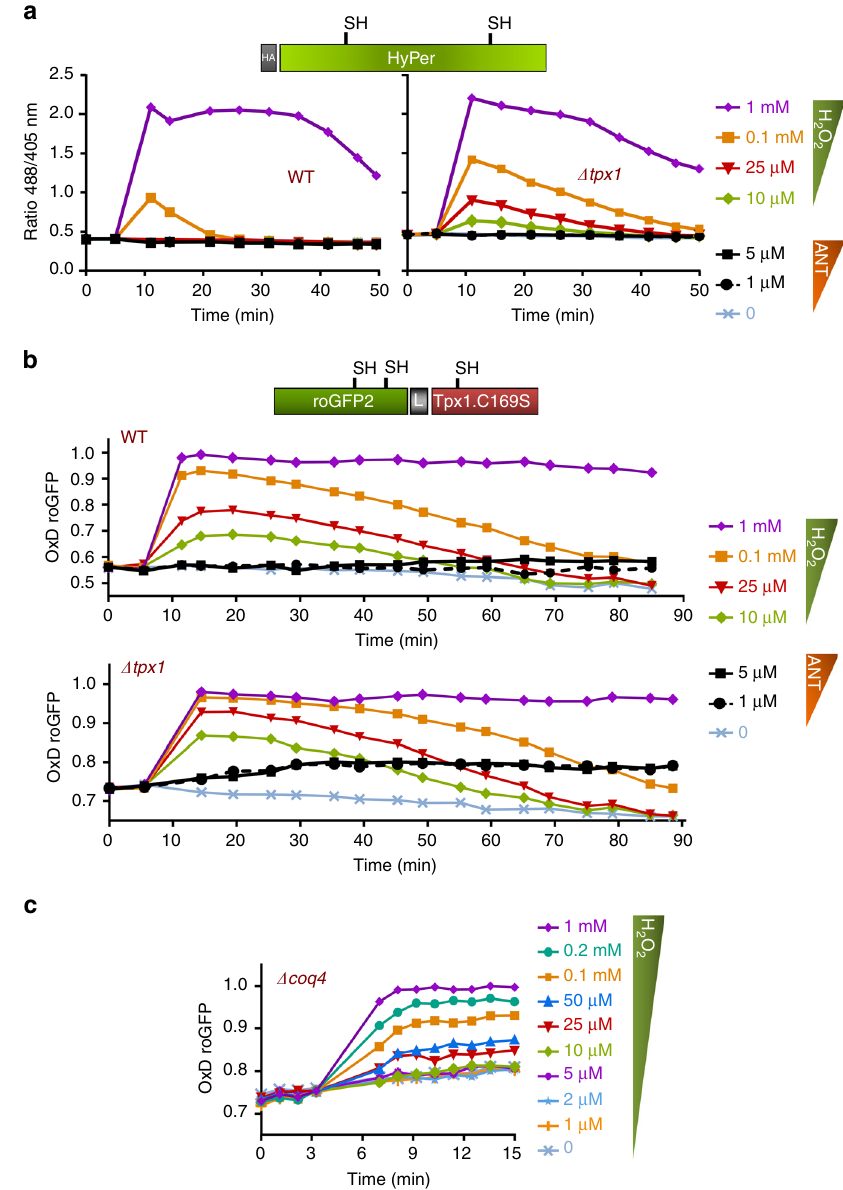
Fig. 5 Cytosolic roGFP2-Tpx1.C169S can detect mitochondrial H 2 O 2 production. Strains HM123 (WT) and SG5 ( Δ tpx1 ) were transformed with plasmids p605 ( a ) and p407.C169S ( b ). The indicated concentrations of H 2 O 2 and antimycin A (ANT) were directly added to MM cultures and oxidation of the reporters was estimated as described in Fig. 1; oxidation of the probe upon ANT treatments is represented with solid (5 µ M ANT) or dashed (1 µ M ANT) black lines. a Data from two biological replicates are shown, with error bars (S.D.) displayed in Supplementary Fig. 7a. b Data from two (WT) or three ( Δ tpx1 ) biological replicates are shown, with error bars (S.D.) displayed in Supplementary Fig. 7b. c Strain Δ coq4 was transformed with plasmid p407.C169S and H 2 O 2 treatments were performed and oxidation of the reporter estimated as described in Fig. 1. Data from three biological replicates are shown, with error bars (S.D.) displayed in Supplementary Fig.